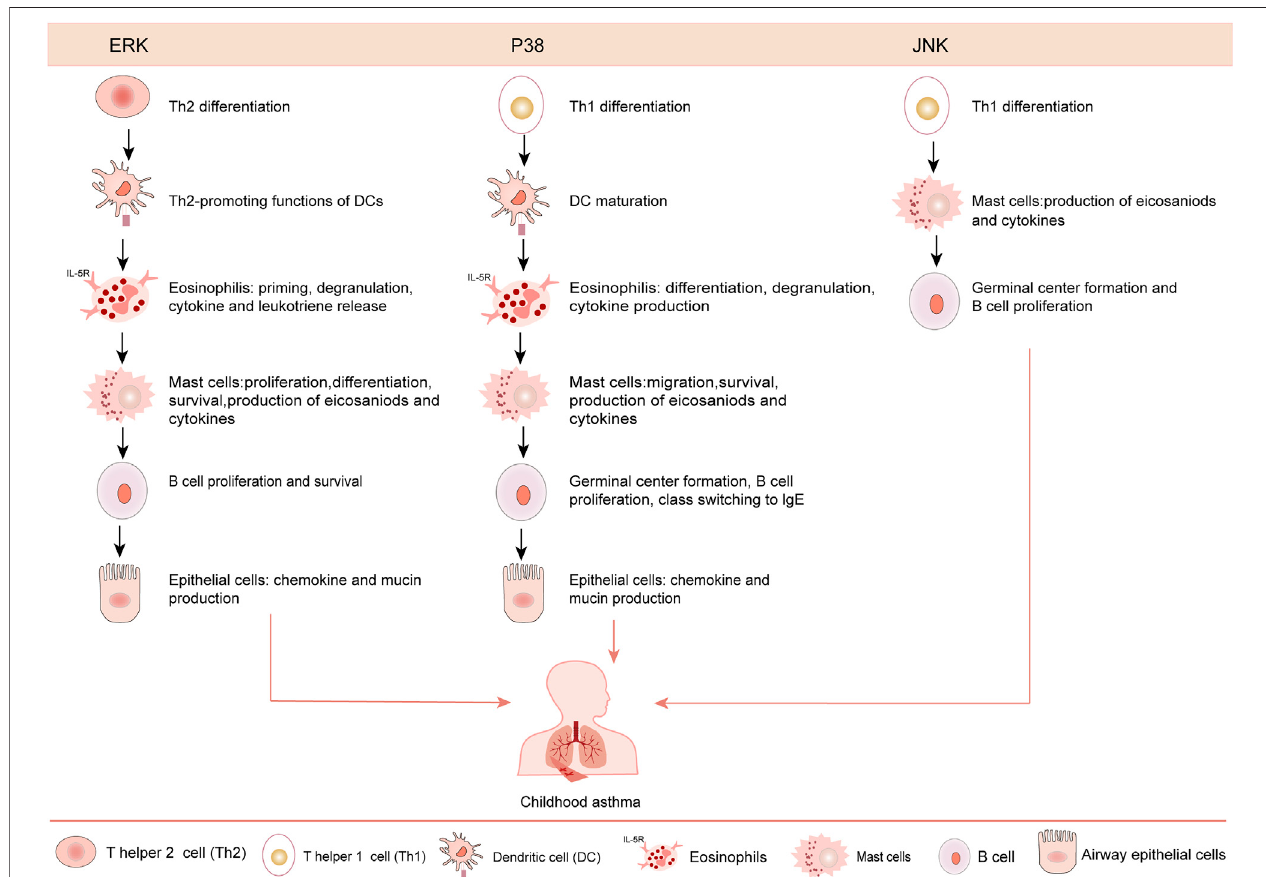
FIGURE3 | Roles ofvarious MAPK signaling pathways in asthmatic pathogenesis.ERK favors Th2 cell differentiation, eosinophils priming, degranulation, cytokine and leukotriene production, mast cells proliferation/differentiation. The p38 MAPKs and JNK pathways regulate Th1 differentiation. The p38 MAPK contributes to eosinophil degranulation, migration and cytokine production and mast cell migration. The JNK participates in cytokine production by mast cells, regulates the proliferation of B cell, and exerts function in asthmatic pathogenesis.